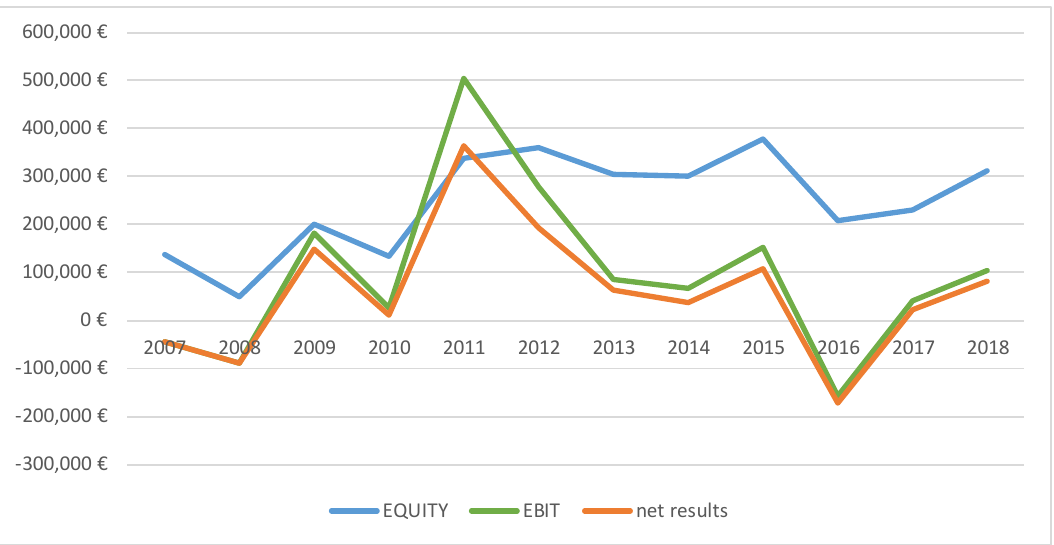
Figure 3. CML’s main financial indicators (2007– 2018).